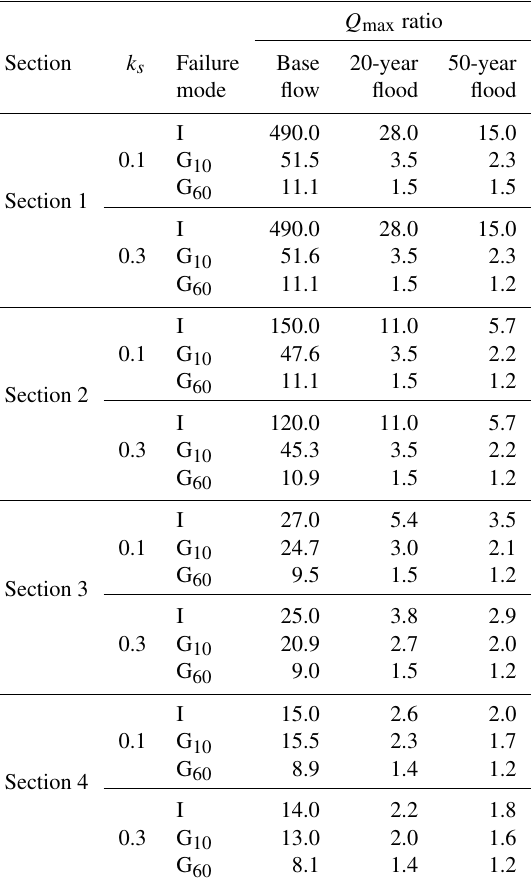
Table 9. Ratio between the peak discharge following dam breaching and the discharge in the pre-failure flow conditions in sections 1 to 4, considering two different roughness heights ( k s = 0.1m and and 50-year